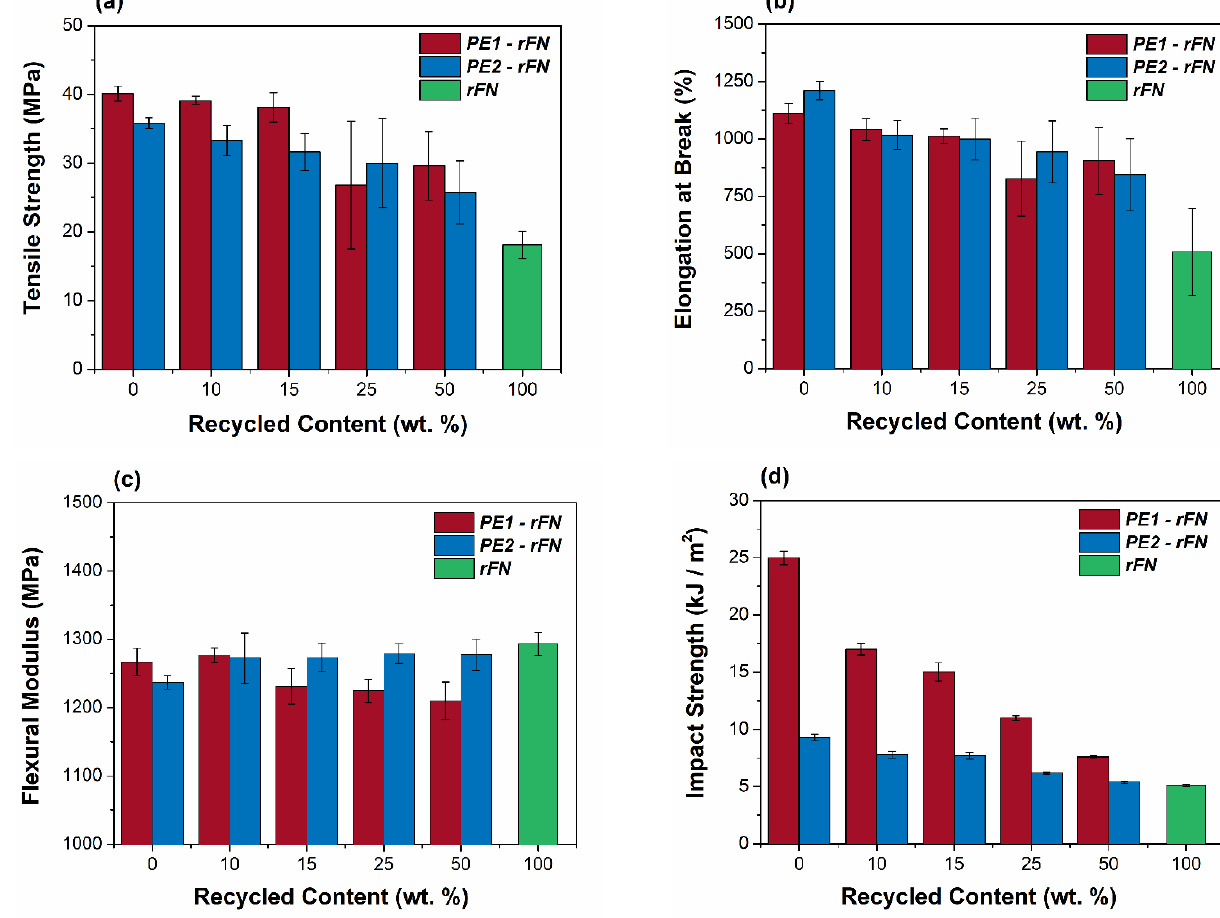
Figure 2. ( a ) Tensile strength, ( b ) Elongation at break, ( c ) Flexural modulus and ( d ) Impact strength resistance results for PE1—rFN and PE2—rFN systems.